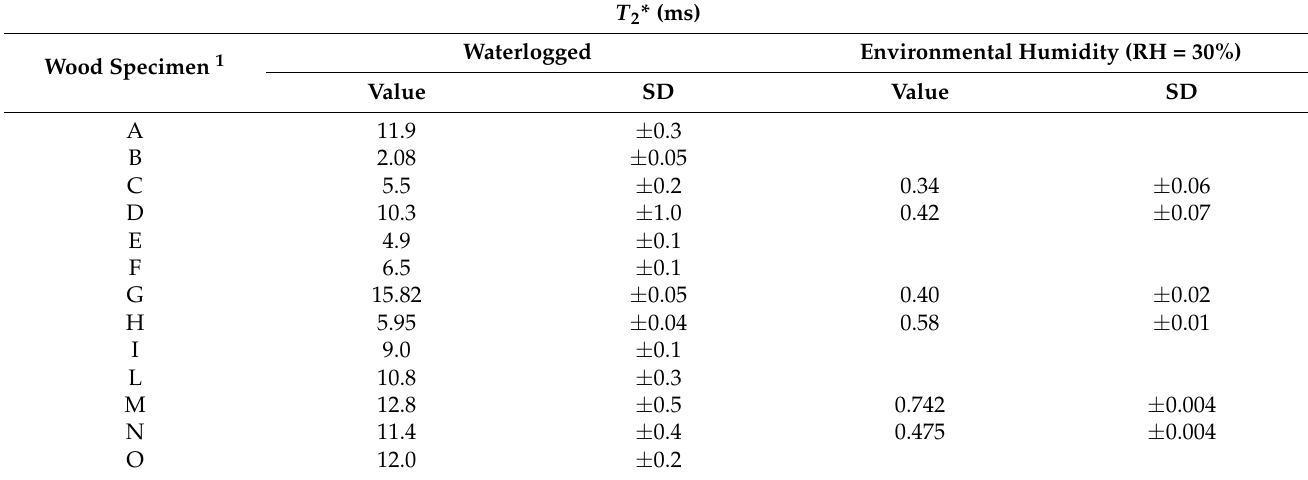
Table 5. T 2 * of 100% soaked and RH = 30% wood